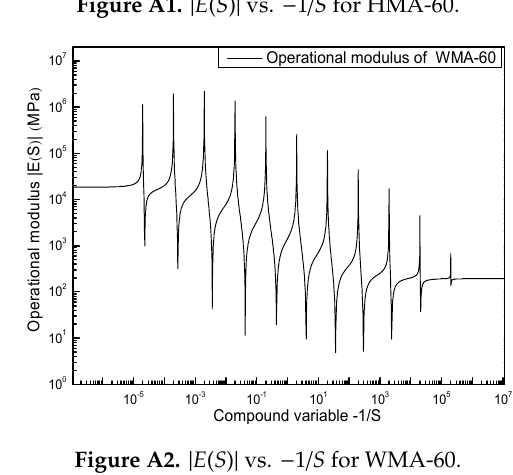
Figure A2. | E ( S ) | vs. − 1 / S for WMA-60.